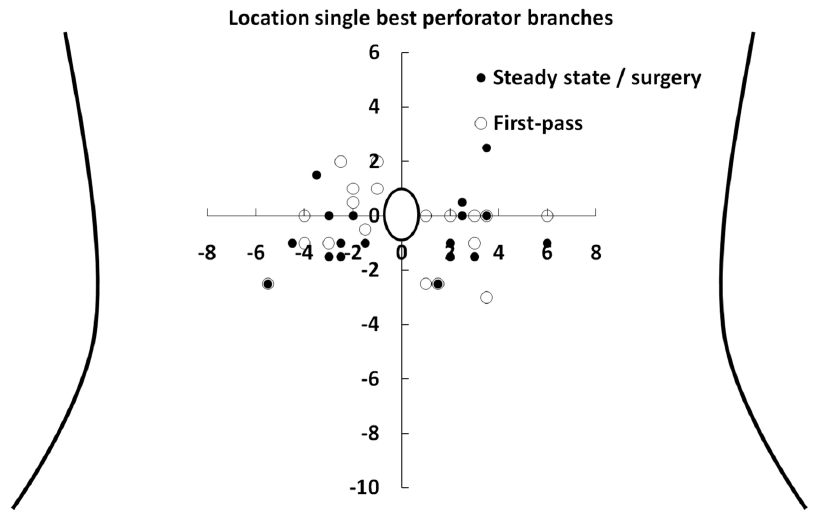
Figure 2. Schematic overview of the best perforator branch of the deep inferior epigastric artery. Schematic overview of the abdomen and the location of the single best perforator branches of the deep inferior epigastric artery found and used during DIEP dissection. The x- and y-axis represent the distance (in cm) in respect to the umbilicus. These perforator branches correlated with equilibrium-phase results for 100%. Only those perforator branches with a first-pass acquisition of diagnostic quality are presented, allowing a 1:1 comparison between equilibrium-phase high spatial resolution and first-pass CE-MRA.